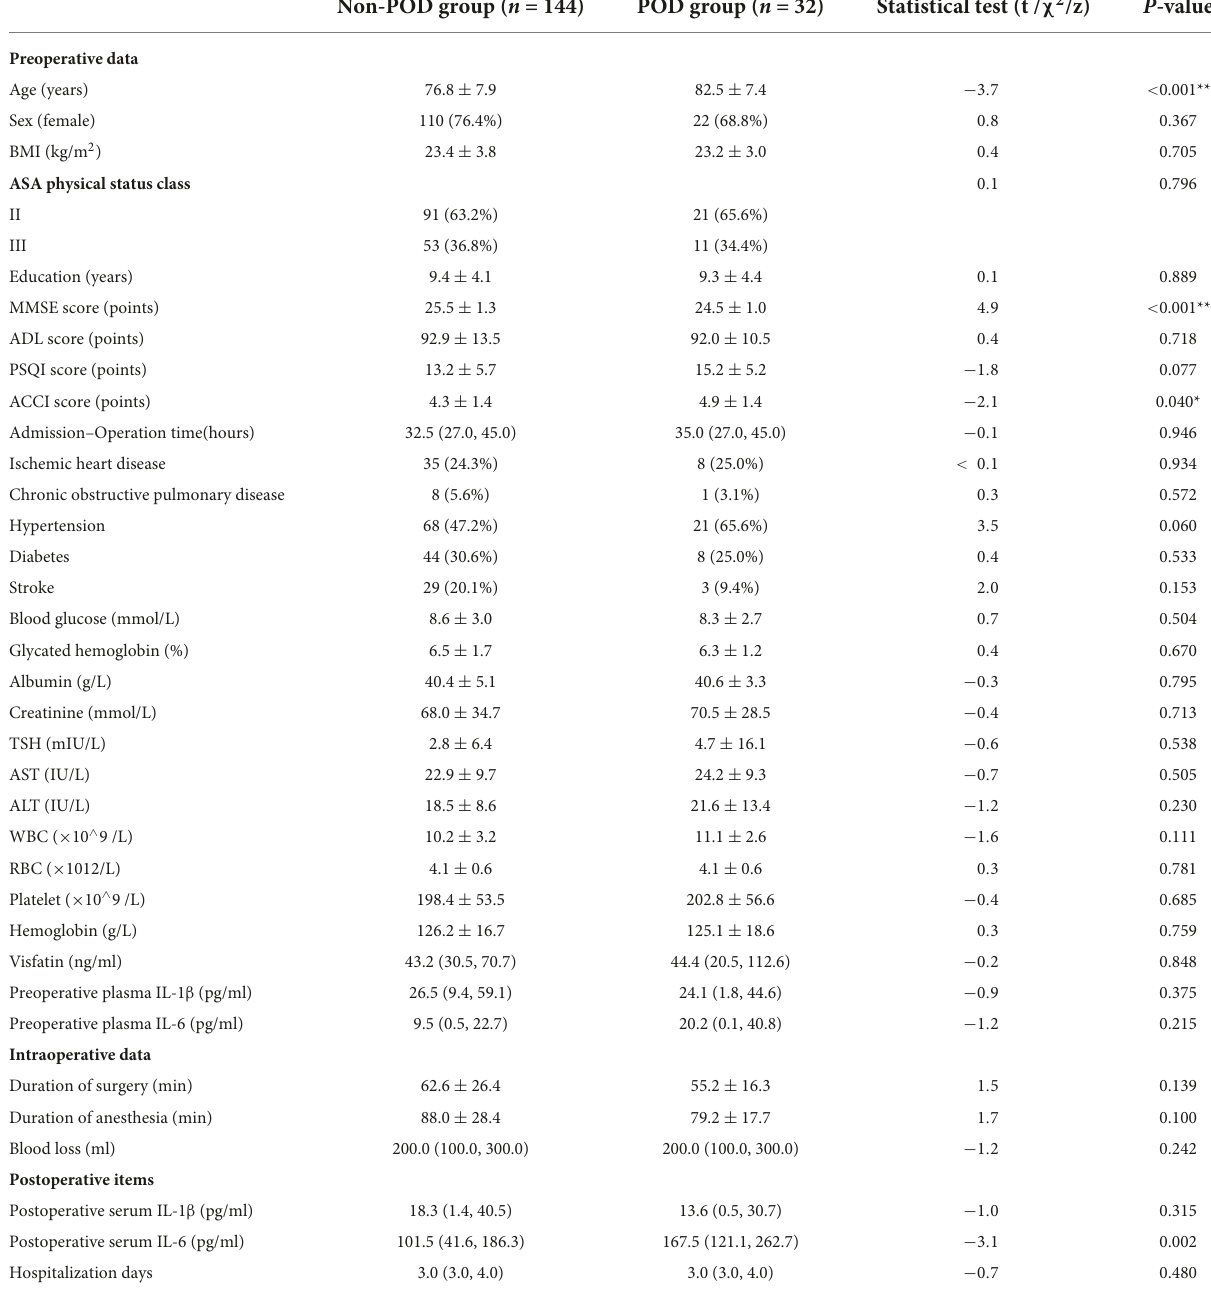
TABLE 1 Associations between perioperative variables and postoperative